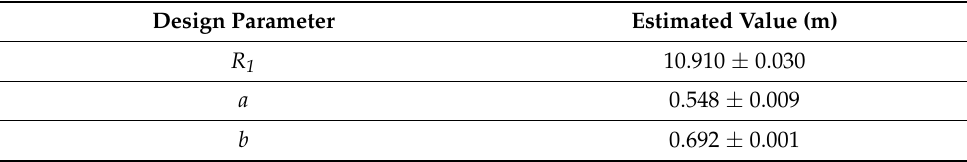
Table A1. Design parameters of the Makyneia theatre (adjusted